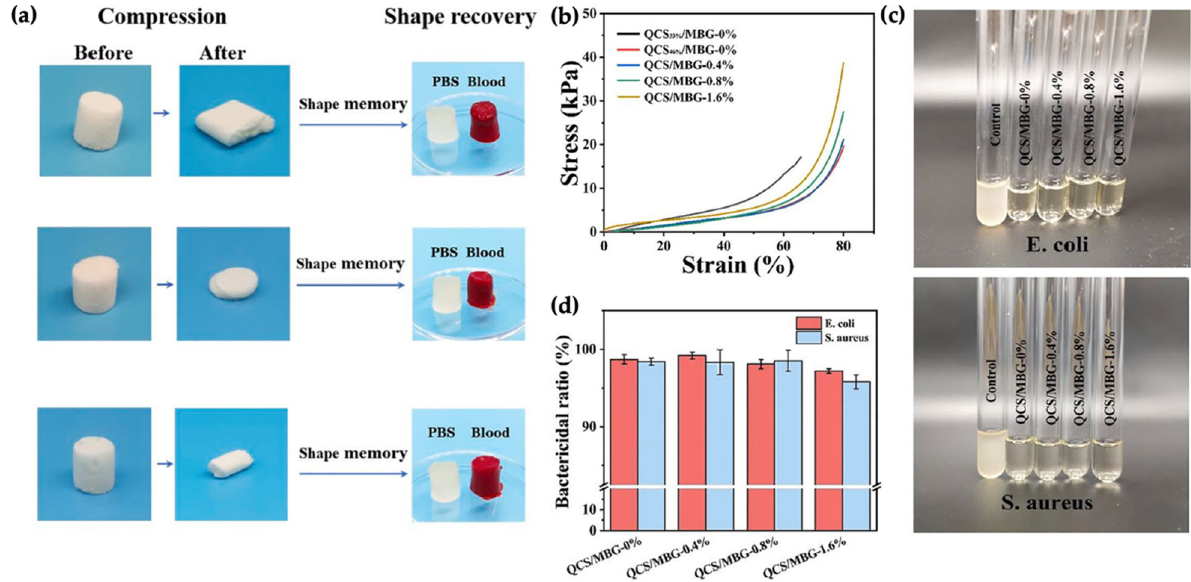
Figure 12. The mechanical properties and antibacterial pursuit of shape memory elastomers; ( a ) the proposed mechanism of shape recovery using blood absorption, ( b ) compressive mechanical properties of QCS/MBG samples, ( c ) E. coli and S. aureus suspensions incubated with cryogels, and ( d ) bactericidal ratio of cryogels against E. coli and S. aureus [92]. Adapted from [92], Copyright 2022, with permission from Elsevier.